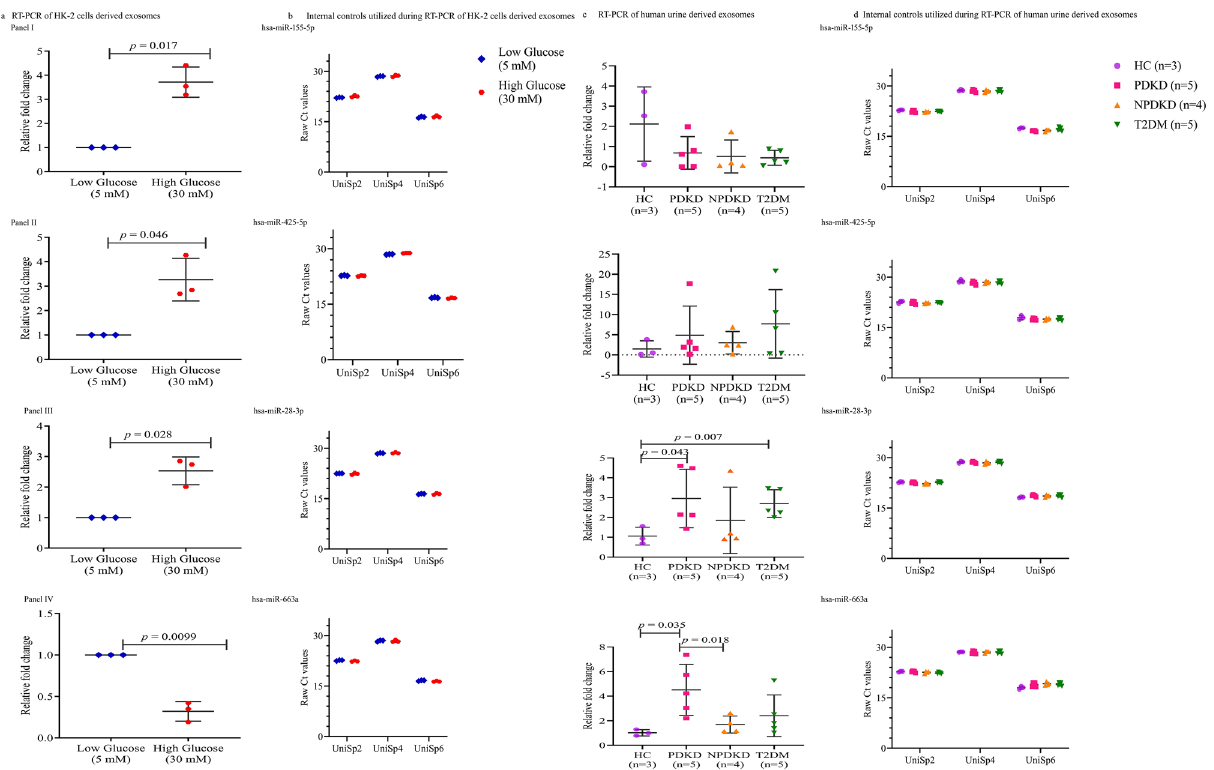
Figure 3. Validation of enriched miRNAs from HK-2 cells and human urine-derived exosomes by Real-Time PCR and their internal controls. hsa-miR-155-5p (Panel I), hsa-miR-425-5p (Panel II), hsa-miR-28-3p (Panel III) and hsa-miR-663a (Panel IV) were analyzed for their expression in ( a ) HK-2 cells-derived exosomes (n = 3). These cells were treated with 5 mM and 30 mM glucose for 96 h before exosome isolation. ( c ) Human urine-derived exosomes from HC, PDKD, NPDKD and T2DM. Relative fold change = (2^- (delta delta Ct)). UniSp2 and UniSp4 were used to estimate the RNA isolation quality; UniSp6 was used as a cDNA synthesis control for ( b ) HK-2 cells derived exosomes ( d ) human urine derived exosomes. In all scatter plots, the centre line represents the mean; the smallest number in the data set was shown at the end of the lower whisker; the largest number in the data set was shown at the end of the upper whisker as determined by the GraphPad Prism version.7.0 software. Normally distributed samples were analyzed by two-tailed Student’s tests otherwise by 2 Diabetes